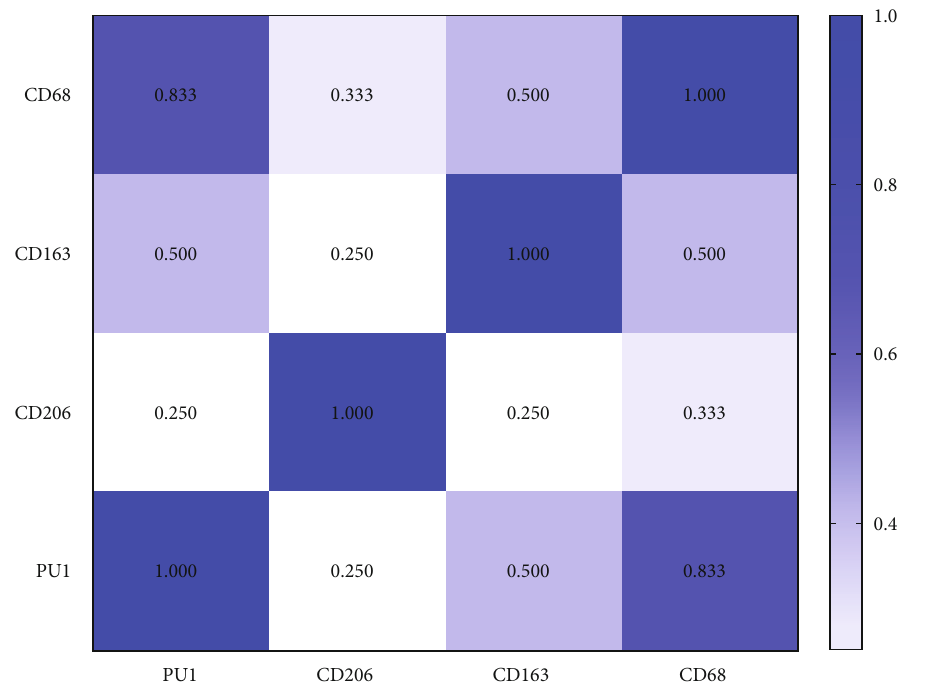
Figure 2: Spearman ’ s rank correlation coe ffi cient for macrophage markers.